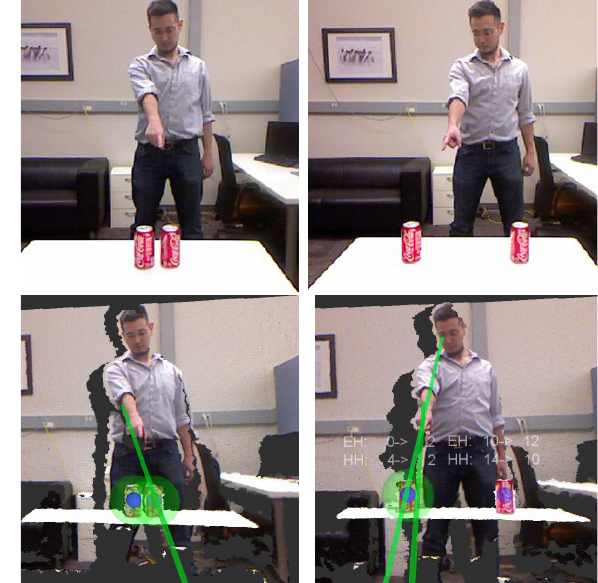
Figure 9: Example scenarios from the object separation test are shown. Our experiments covered separations between 2 cm (left images) and 30 cm (right images). The object is comfortably distin- guished for the 30 cm case, whereas the intended target is ambigu- ous when the targets are 2 cm apart. Second row shows the point cloud from the RGB-D camera’s view. Green lines show the Elbow- Hand and Head-Hand directions whereas green circles show the objects that are within the threshold D mah < 2